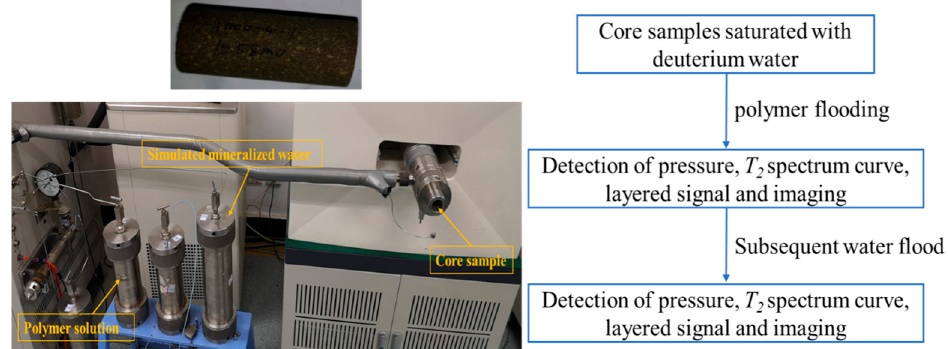
Figure 5. Experimental schematic